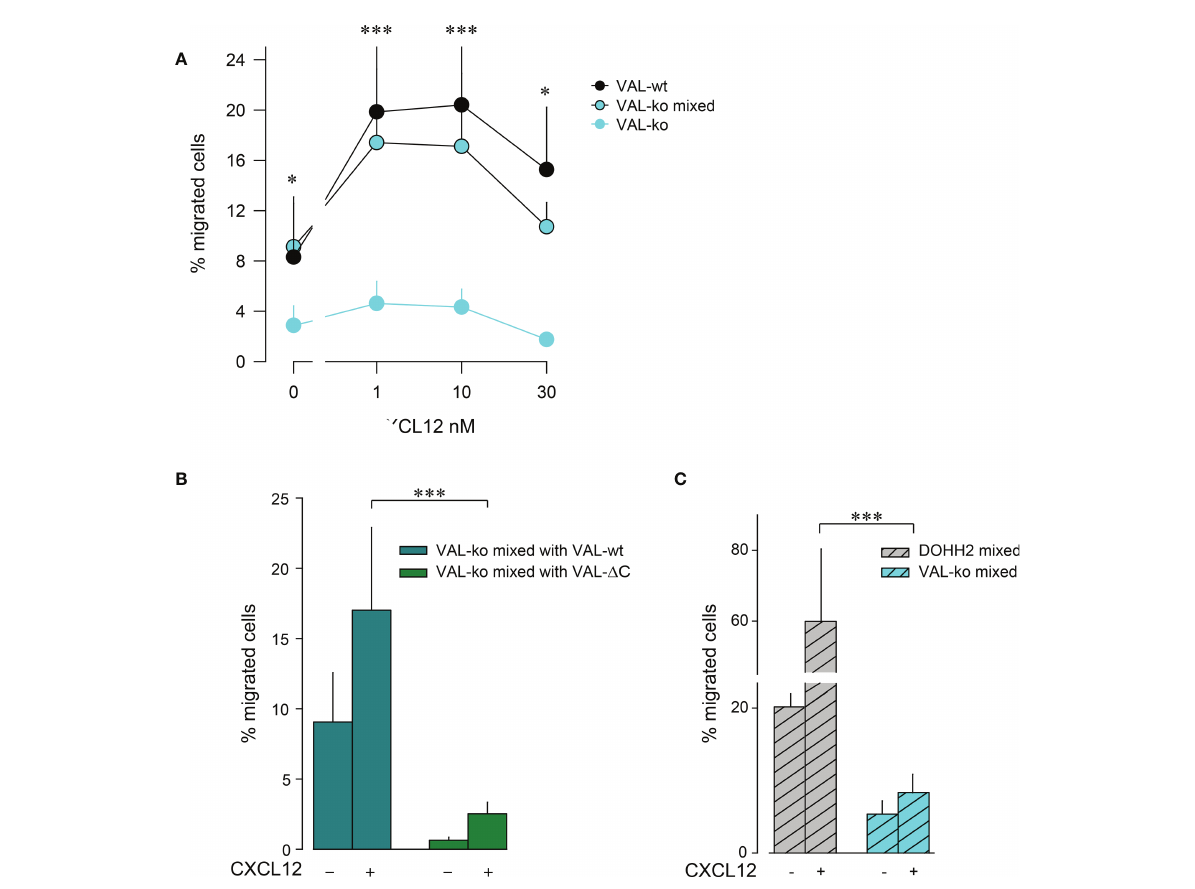
FIGURE 2 VAL-wt cells induce the migration of VAL-ko cells. (A) Transendothelial migration of VAL cells (as in Figure 1) towards different concentrations of CXCL12 (1, 10, 30 nM). Cyan symbols and cyan lines (VAL-ko) displays % migrated VAL-ko in the absence of VAL-wt. The % migrated